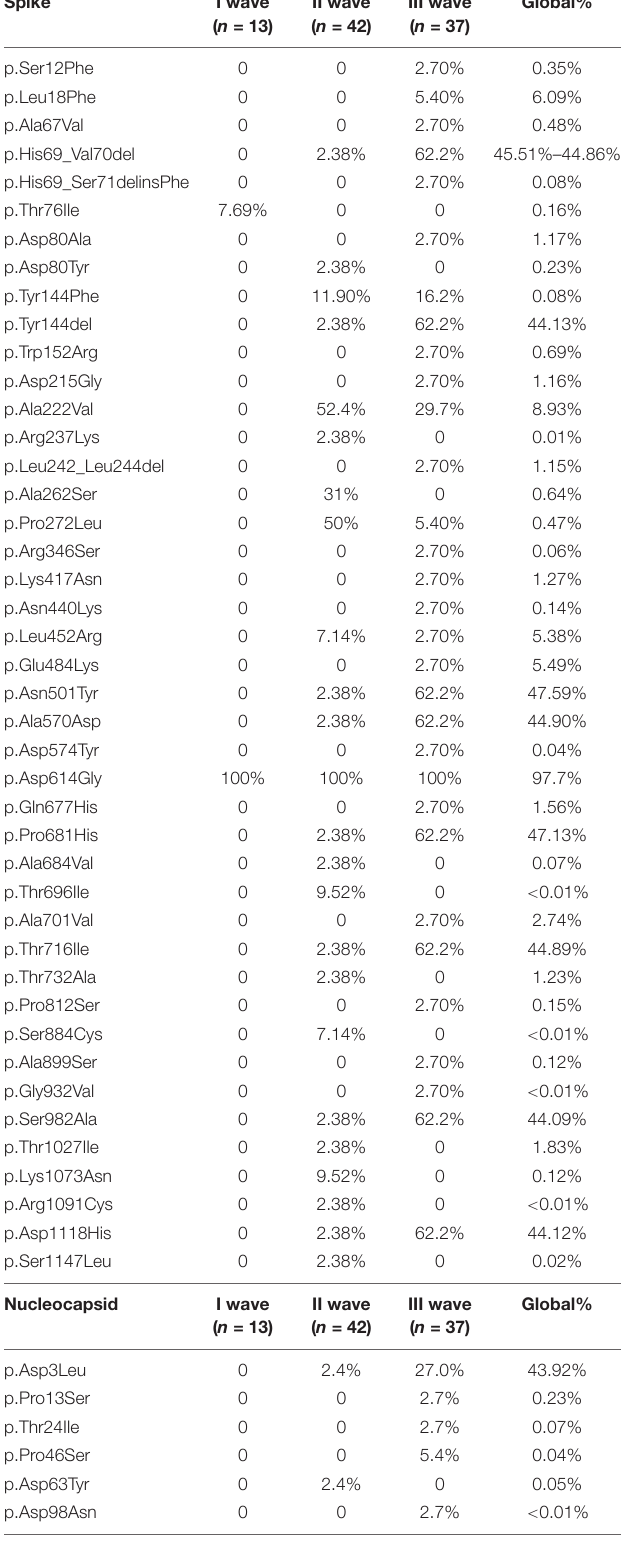
TABLE 4 | Amino acid substitutions in spike, nucleocapsid and nsp12